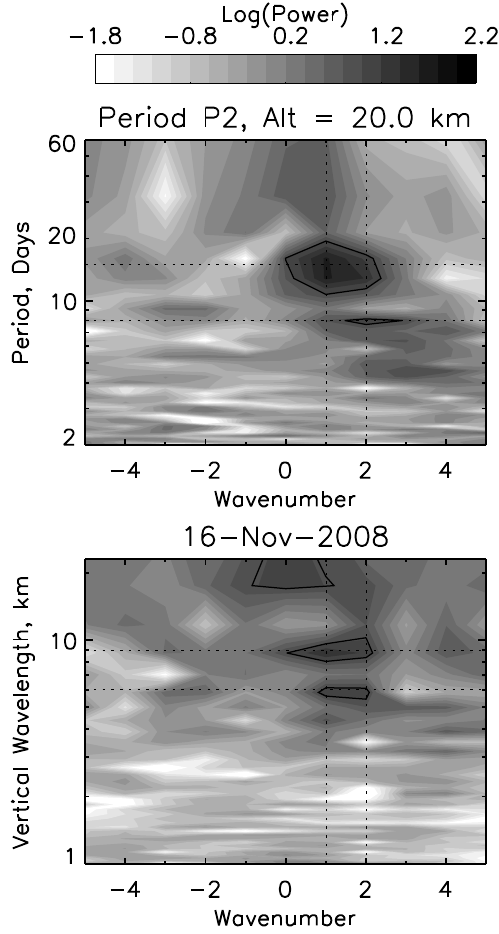
Fig. 5. Top: Two-dimensional Fourier power spectrum of the tem- perature fluctuations at 20km during November–December 2008 (wavenumber-period-power distribution) divided by the back- ground noise spectrum. Wavenumbers 1 and 2 at periods 15 and 8 days, respectively, are dominating. Bottom: Two-dimensional Fourier power spectrum of the temperature fluctuations on 16 November 2008 (wavenumber-vertical wavelength-power distri- bution) divided by the background noise spectrum. At wavenum- bers 1 and 2 the dominant vertical wavelengths are 6 and 9km. The thick black contours in both panels show the 95% confidence